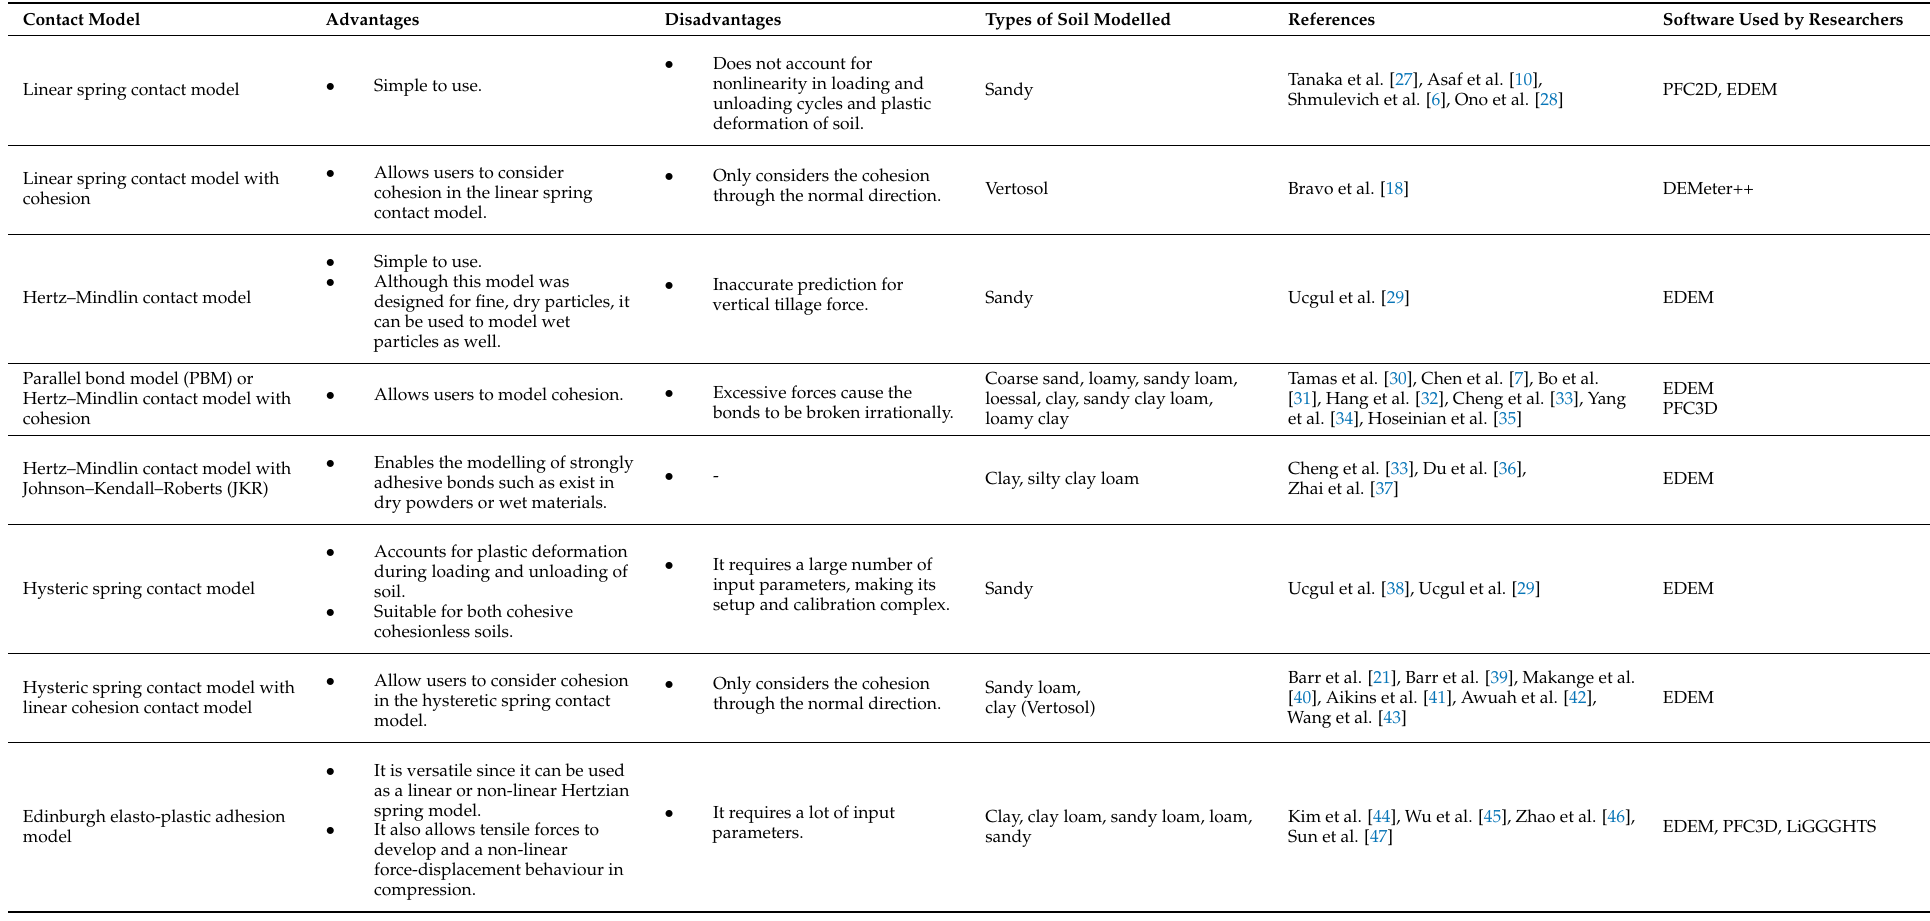
Table 1. Discrete element method contact models, their advantages and disadvantages, types of soil modelled, and software